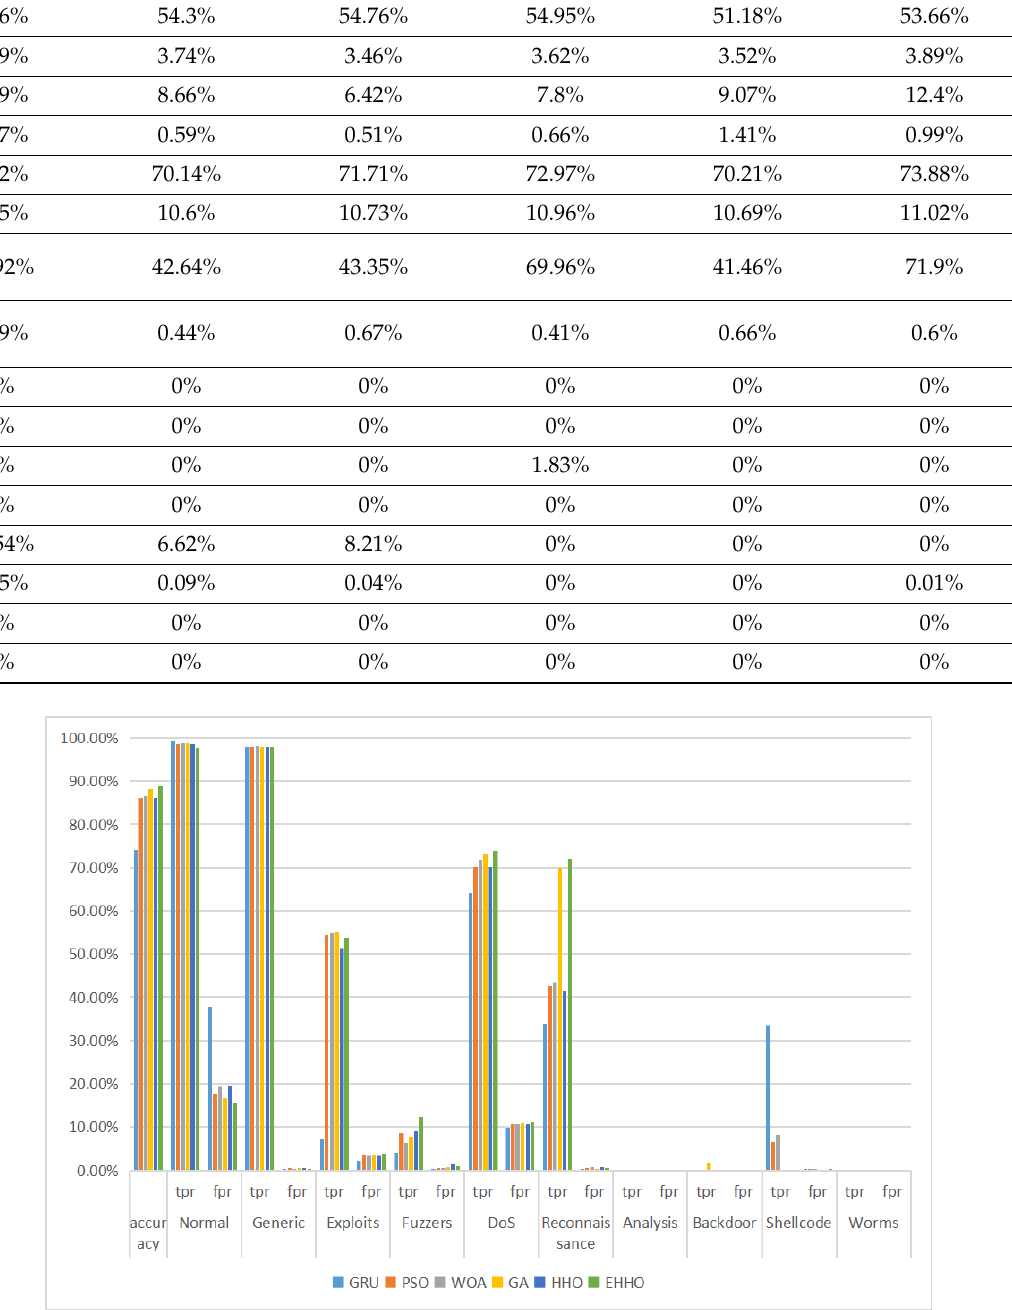
Figure 12. Multi-classification histogram of